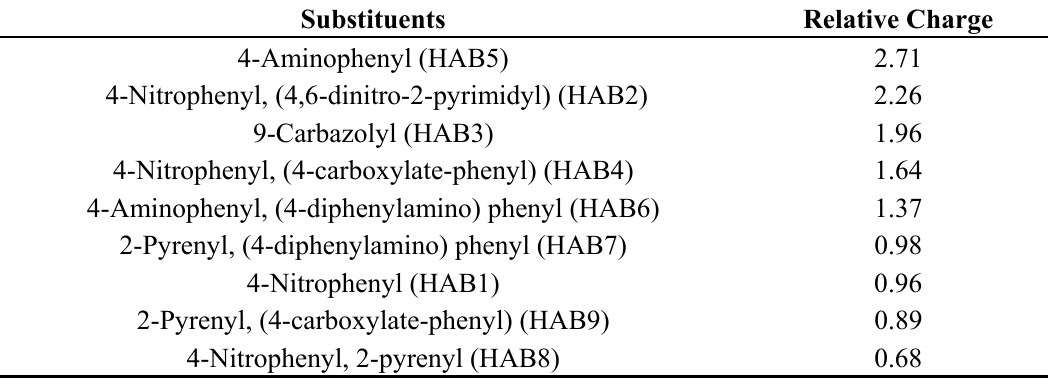
Table 2. Comparison among relative charges of the HAB derivatives under